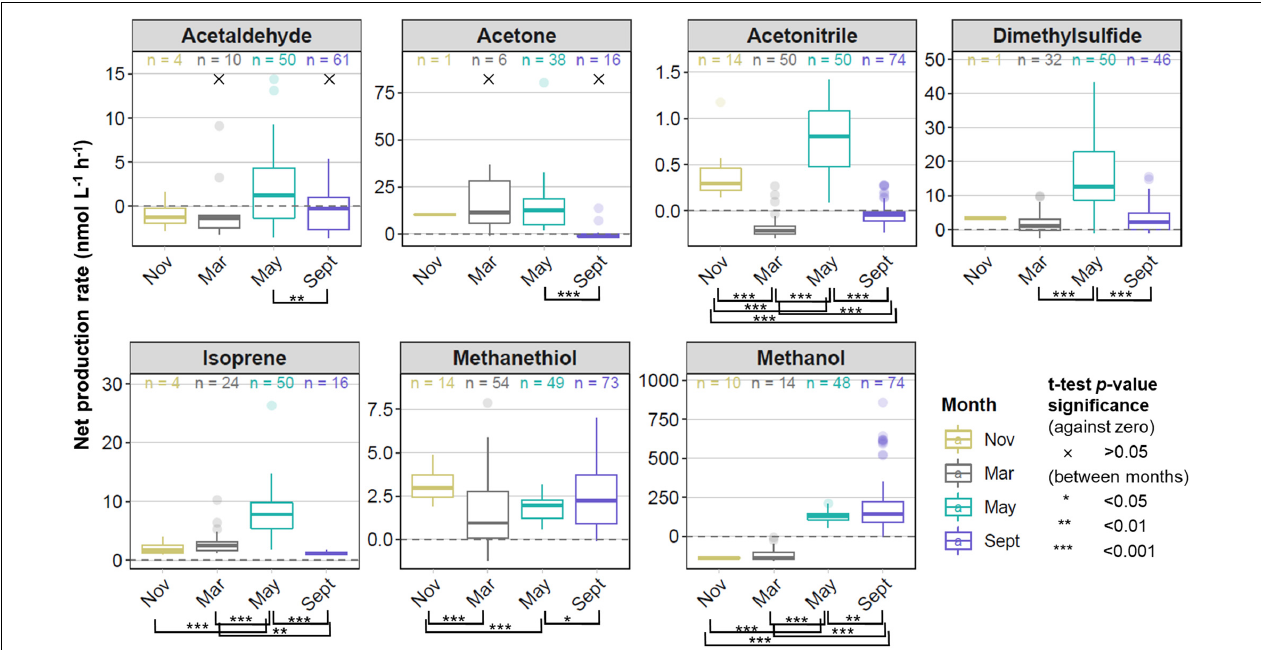
FIGURE 3 | Box and whisker plots showing the range, median, and interquartile range of net VOC production rates for each of four field campaigns that targeted different stages of the annual phytoplankton bloom. Outliers displayed as independent points reflect measurements greater than 1.5 times the interquartile range above and below the median. The number of measurements for each VOC in each month is displayed at the top of each box. These measurements were made from a total of 14, 56, 50, and 74 experiments in November, March, May, and September, respectively. Rates of VOC production that showed no statistical difference ( p > 0.05) from zero are indicated with × . Rates of VOC production that were significantly different between months (pairwise t -tests, p < 0.05) are bracketed and p -value significance indicated with asterisks according to the legend displayed.